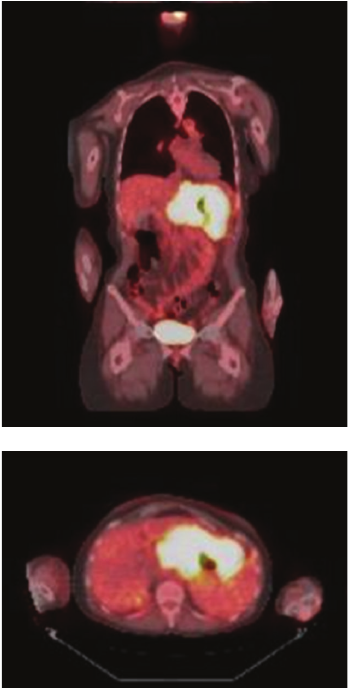
Figure 1: Coronal and cross-sectional PET/CT images demonstrate intense radiotracer uptake in the gastric